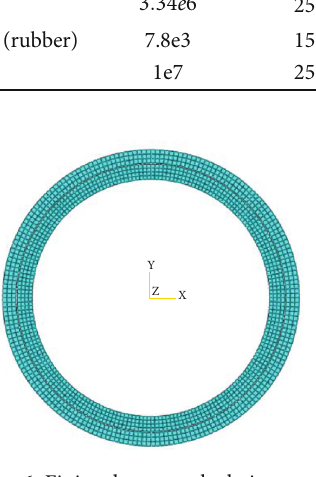
Figure 6: Finite element calculation